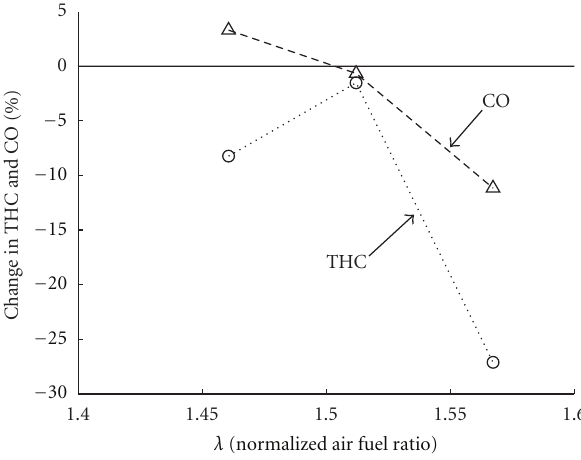
Figure 7: The percent change in carbon-monoxide (CO) emissions and total unburned hydrocarbon (THC) emissions with 1600 mJ of microwave-enhanced ignition from emissions with spark-only ignition. Addition of microwave energy decreases the amount of CO and THC at leaner conditions. A decrease in THC is expected under lean operation with the microwave because more cycles are complete